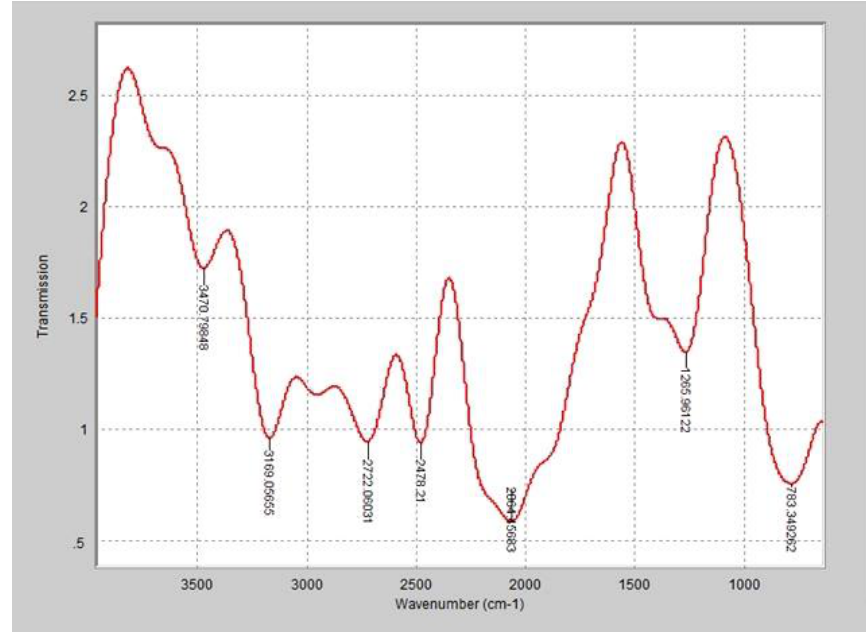
Figure 1. FTIR spectrum of the shell calcined at 900 o C for 3hr